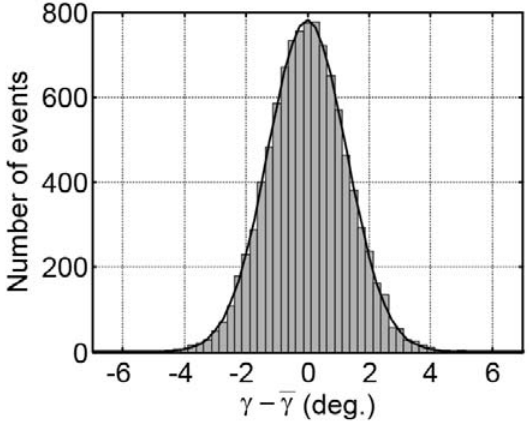
Figure 6. Statistical distribution of deviations of the measured polarization directions of the terahertz waves γ from the mean value (cid:2011)(cid:1191) when we repeat the measurements N = 10,000 times. Each measurement is performed within ~42 ms. The Gaussian fit curve (solid line) with a standard deviation of 0.95° is also